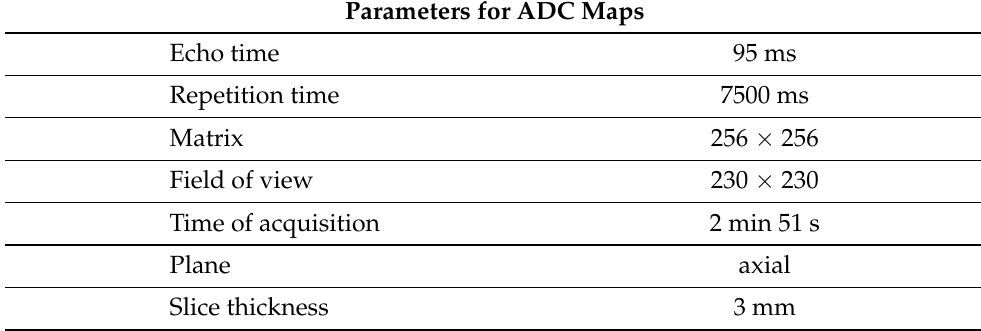
Table 1. Parameters for ADC